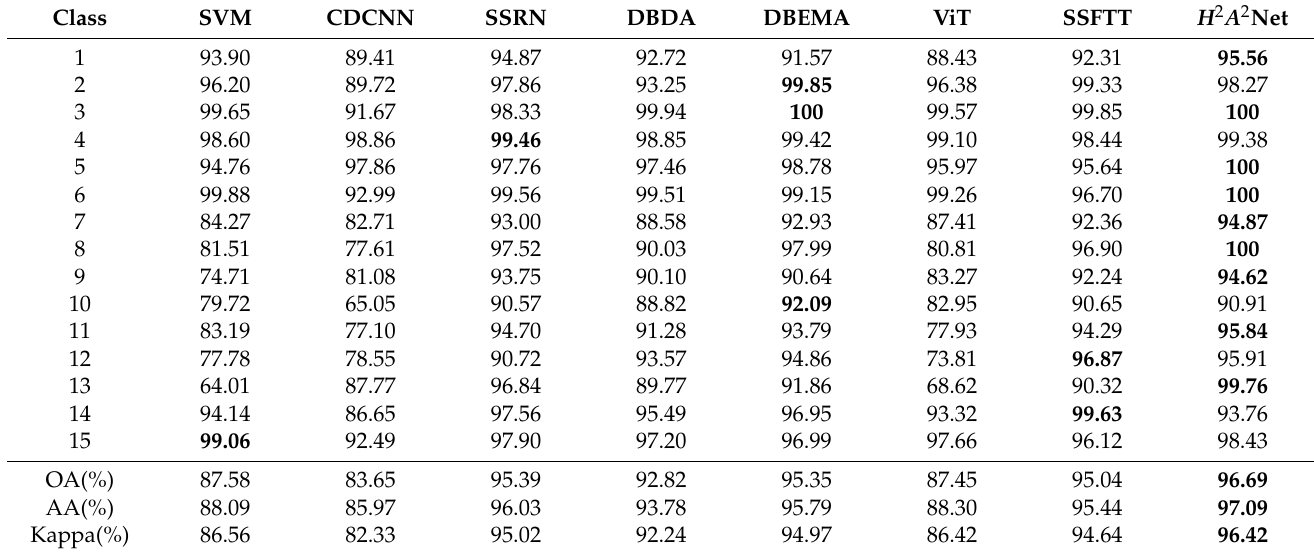
Table 6. The classification accuracy for the SV dataset based on 0.5% training samples. Table 7. The classification accuracy for the HOU dataset based on 3% training